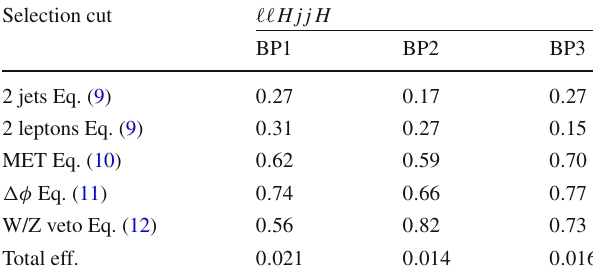
Table 4 Signal selection efficiencies and the total efficiency Selection